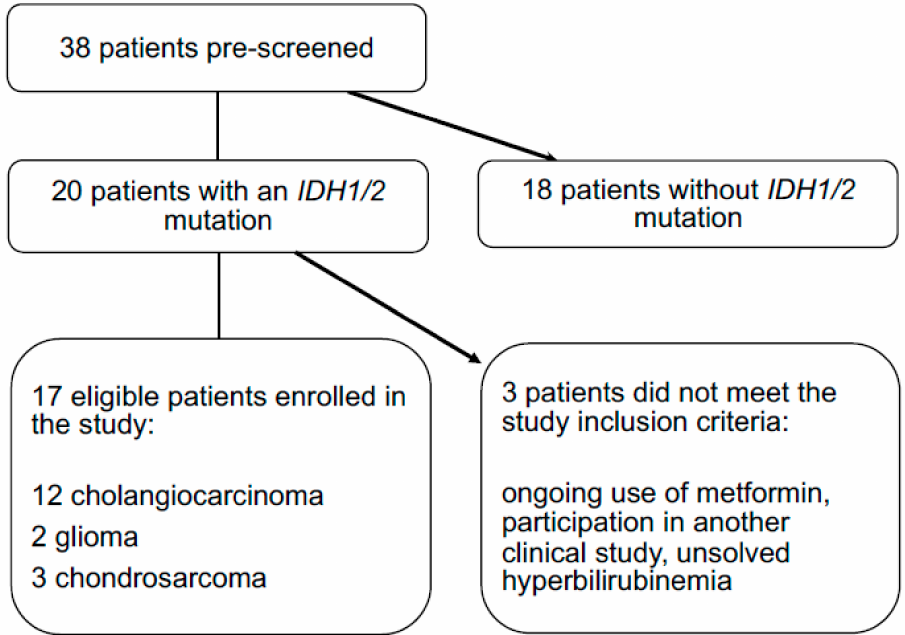
Figure 1. Flowchart showing that 38 patients were pre-screened for the presence of an IDH1/2 mutation. Twenty patients had an IDH1 mutation and 17 patients met the study inclusion